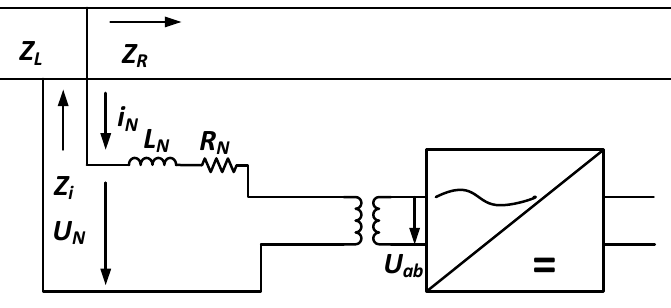
Figure 6. Grid–train coupling diagram.